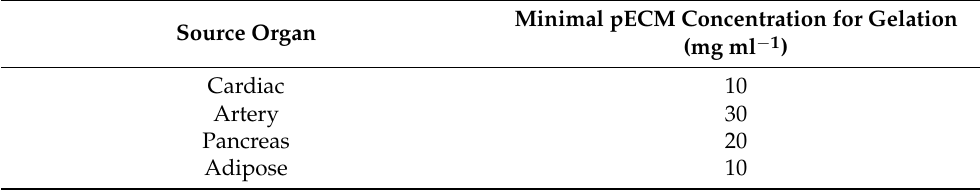
Table 1. Decellularized pECM concentration for hydrogel gelation. Source